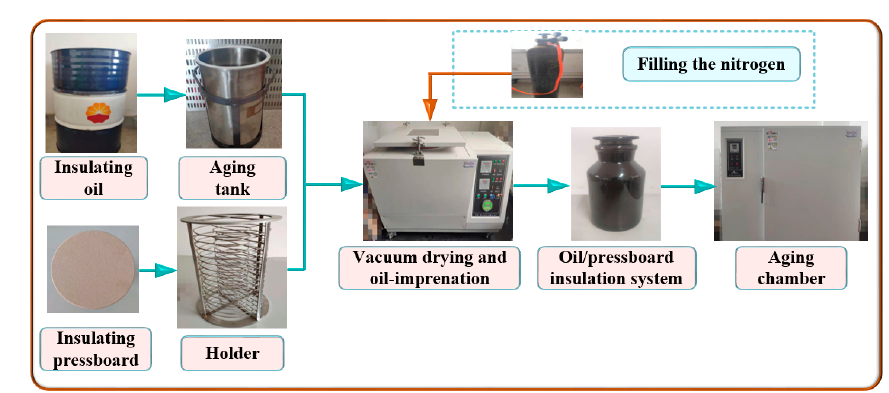
Figure 1. Flow chart of sample pretreatment and accelerated thermal aging experiment.